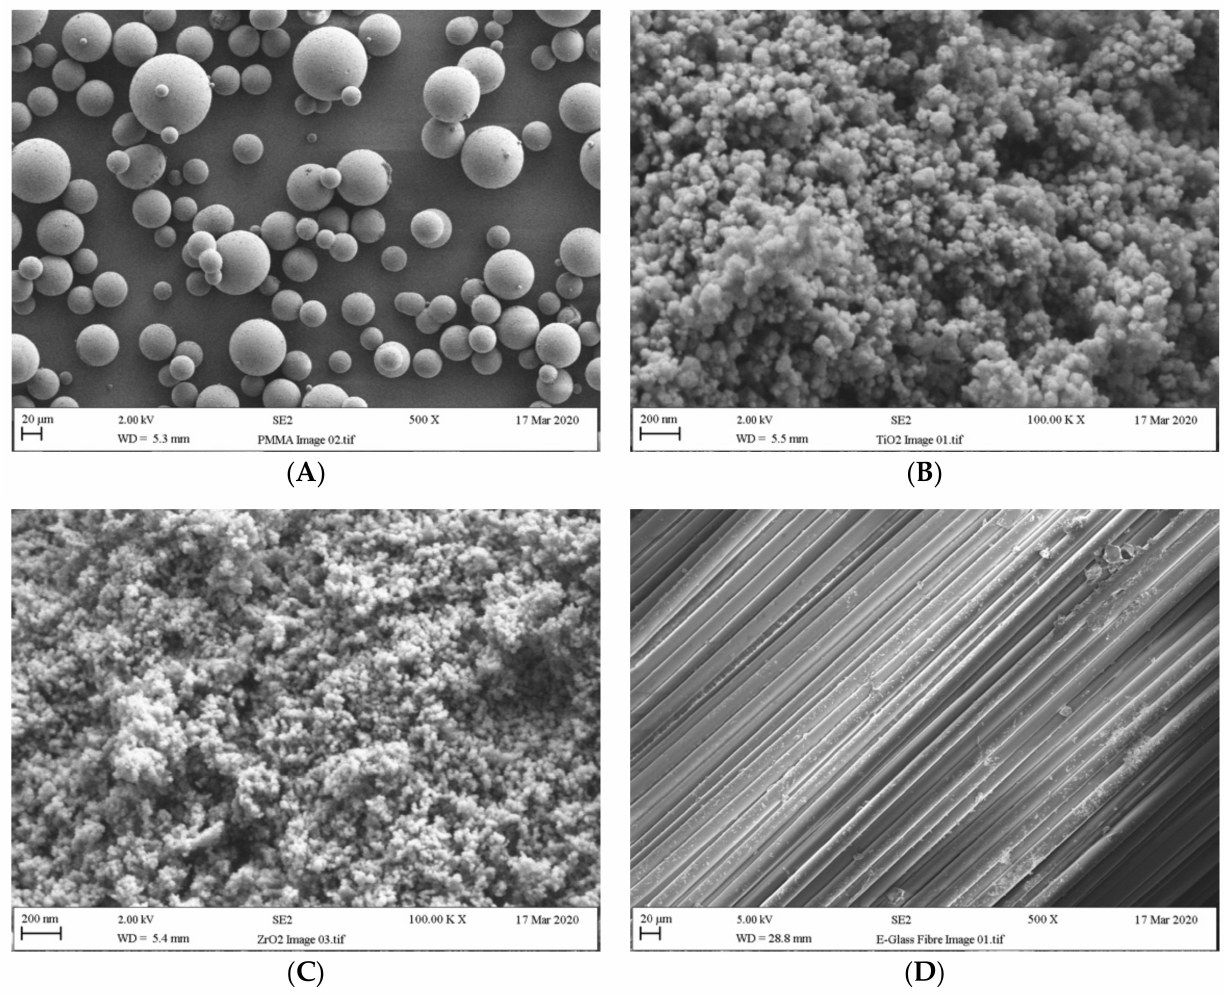
Figure 1. Particle/fibre size of ( A ) PMMA powder, ( B ) ZrO 2 nanoparticles, ( C ) TiO 2 nanoparticles and ( D ) E-glass